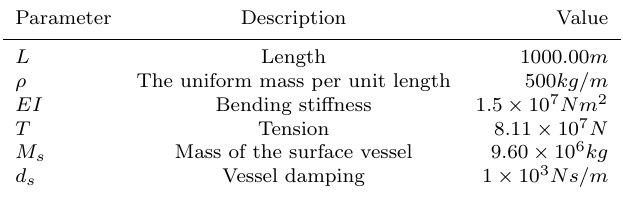
Table 1. The corresponding system parameters.